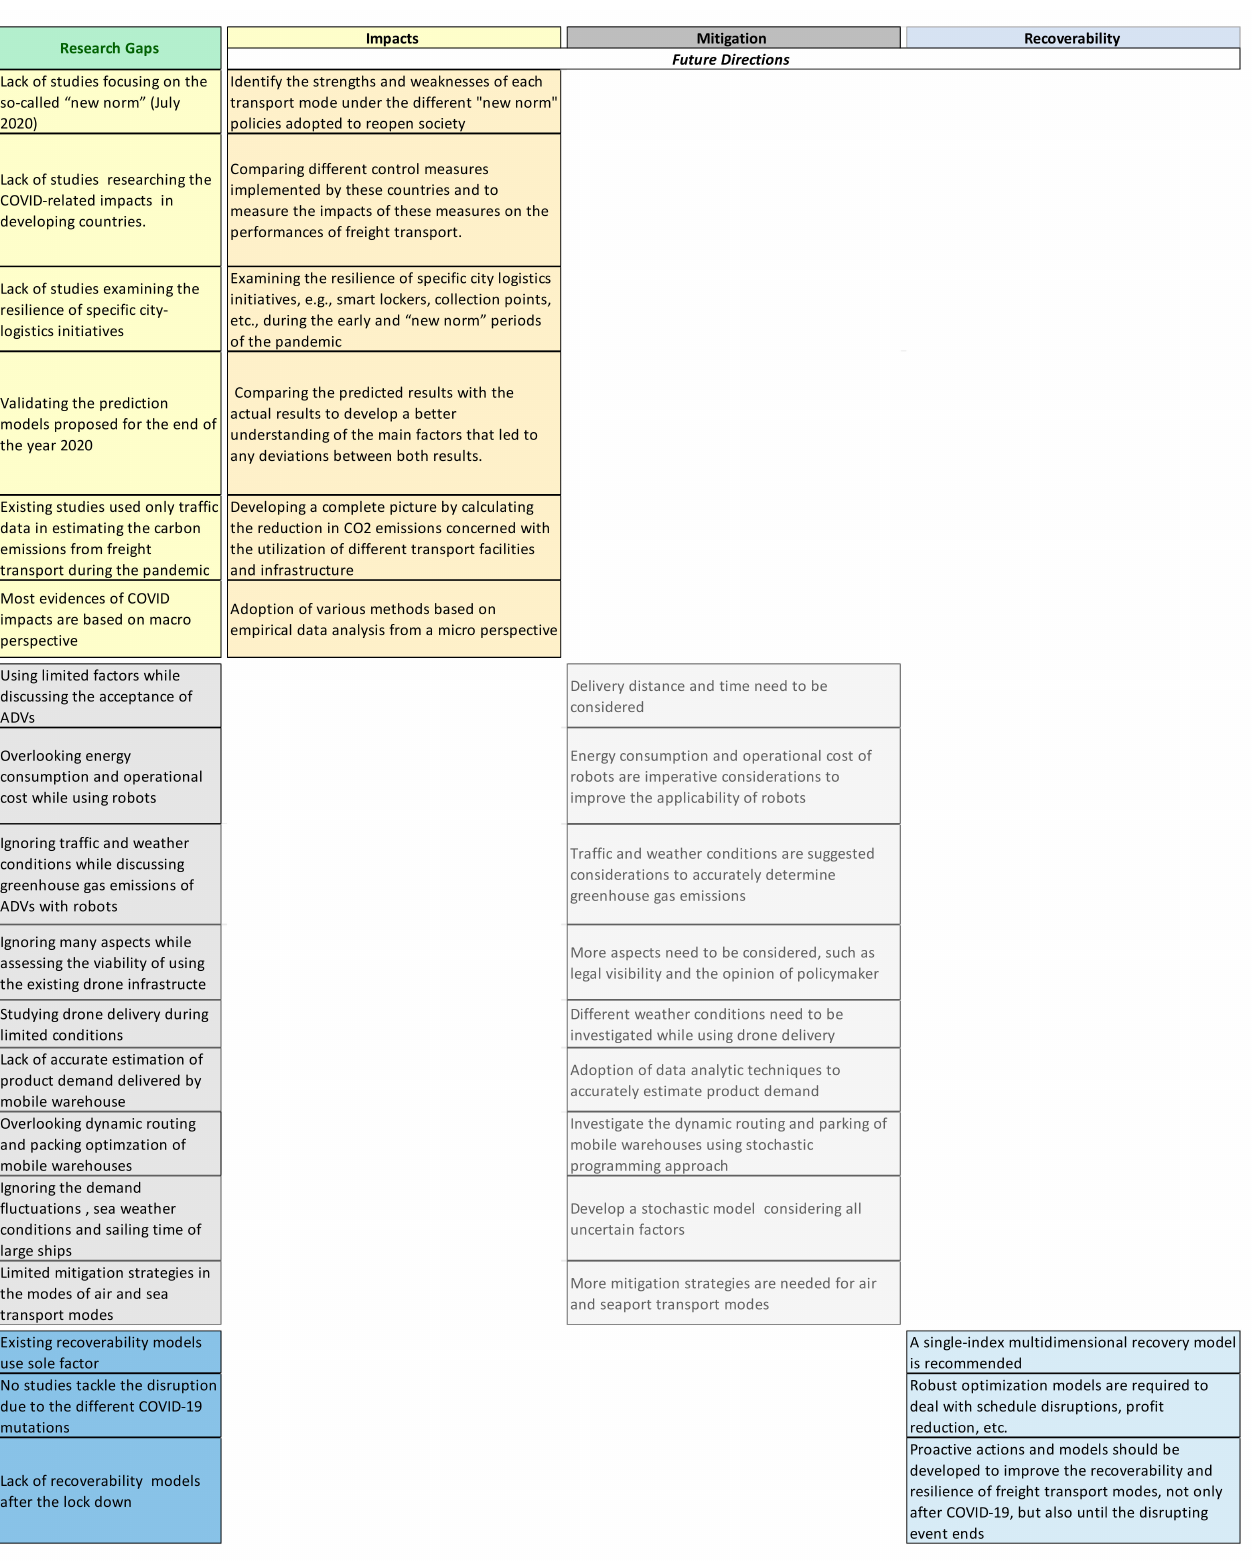
Figure 6. Research gaps and future directions